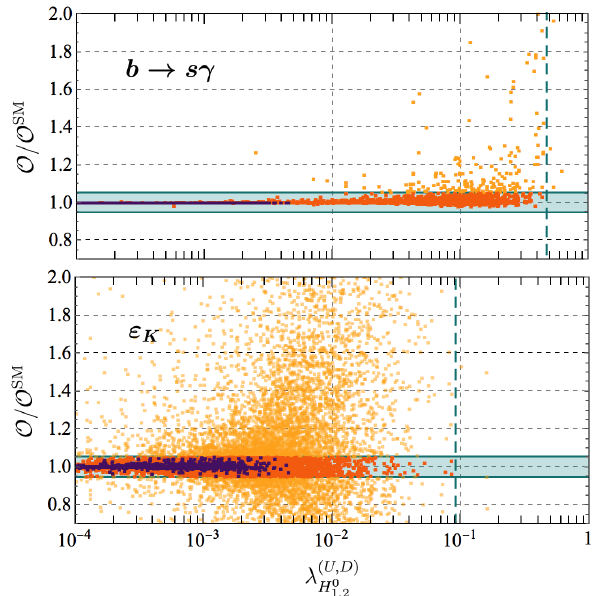
JHEP05(2021)215 Figure 5 . Limits on the effective coupling λ ( U,D ) (vertical dashed lines) coming from the observable H 0 1 , 2 b → sγ (top plot) and the CP observable ε K (bottom plot) respectively. The horizontal band indicates the allowed range. Light yellow points show the full scanned region. Points that satisfy the quark observable are in orange, only dark purple points are compatible with the neutrino observables. Figure 6 . The LFV observable µ → e nuclear conversion versus the effective coupling λ ( U,D ) . The H 0 1 , 2 colours correspond to those of the most restrictive case of figure 5 (bottom